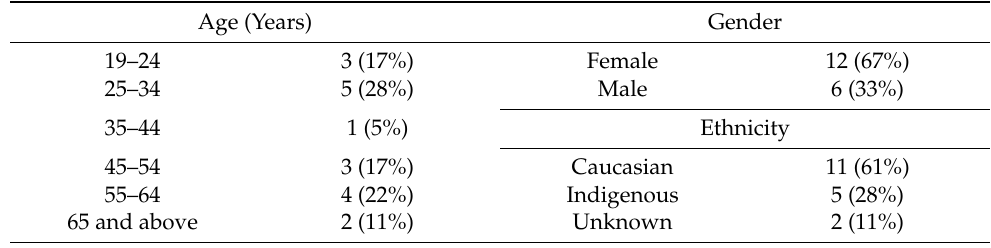
Table 3. Patient demographic and clinical data ( n =